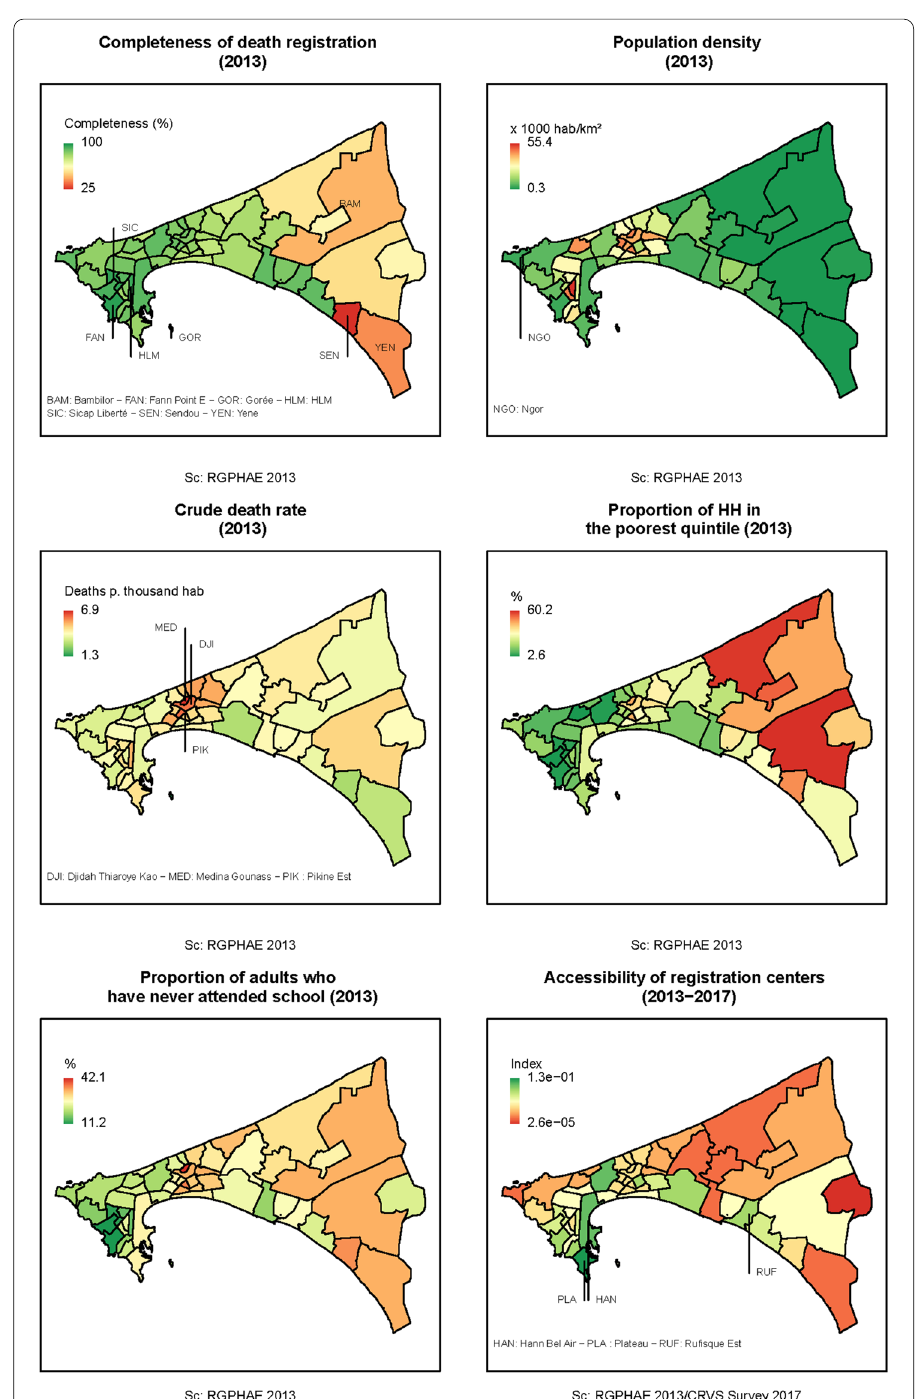
Fig. 2 Completeness of death registration, population density, crude death rate, proportion of households in the lowest quintile, percentage of adults who have never attended school, and accessibility of civil registration centres, at the level of the 52 borough